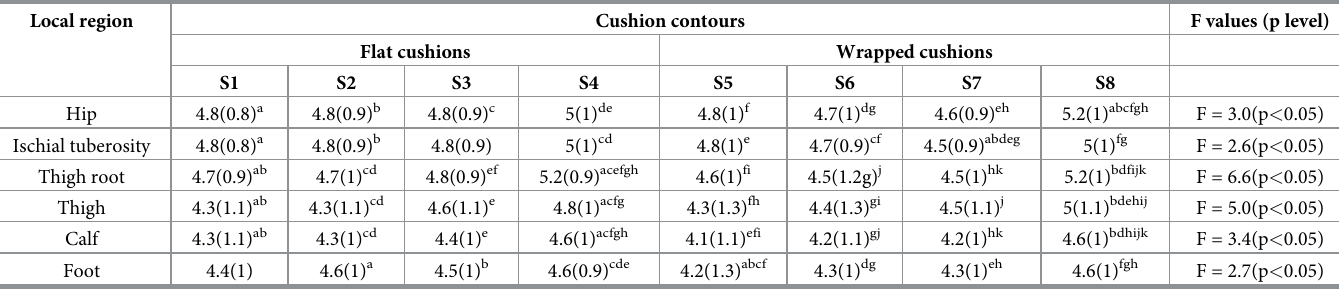
Table 3. Local body region comfort rating variables (values in parentheses indicate a standard error).